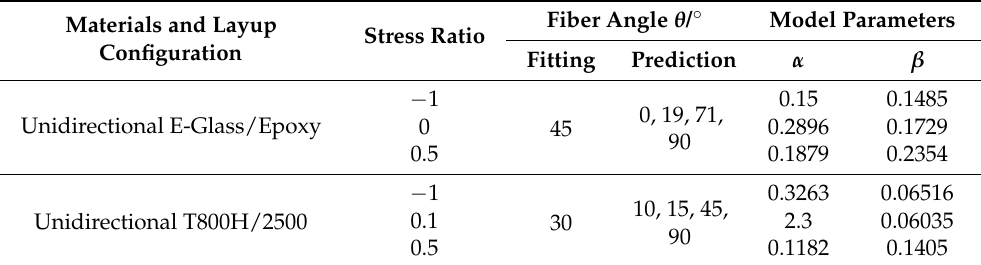
Table 5. Determination of model parameters considering fiber orientation